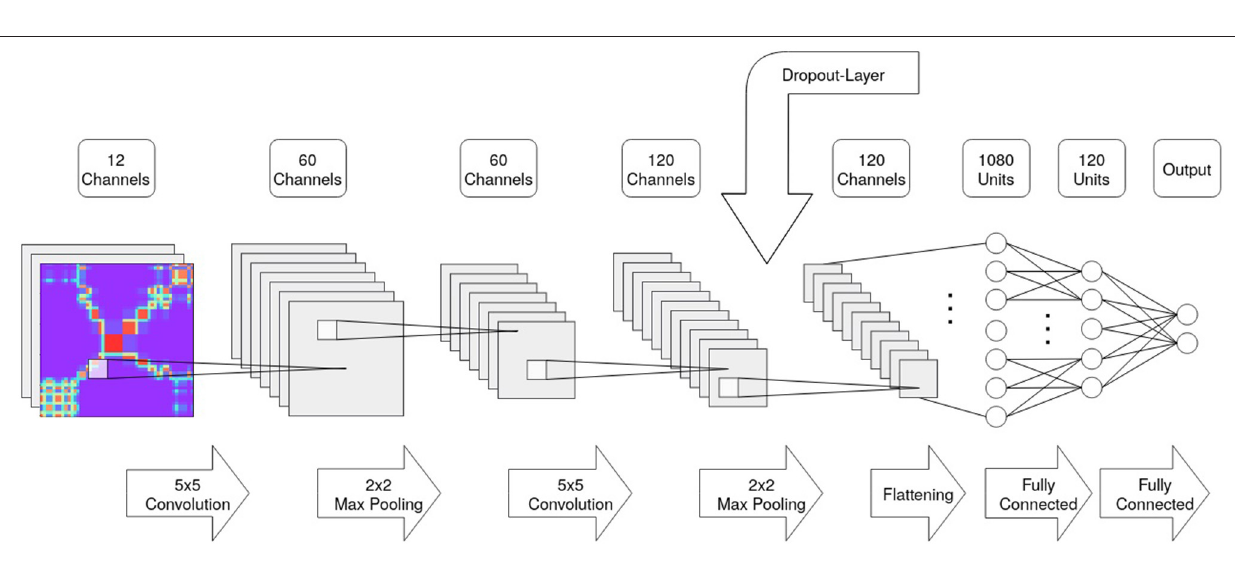
FIGURE 7 | Schematic description of the SimpleNet structure indicating layer size and number of